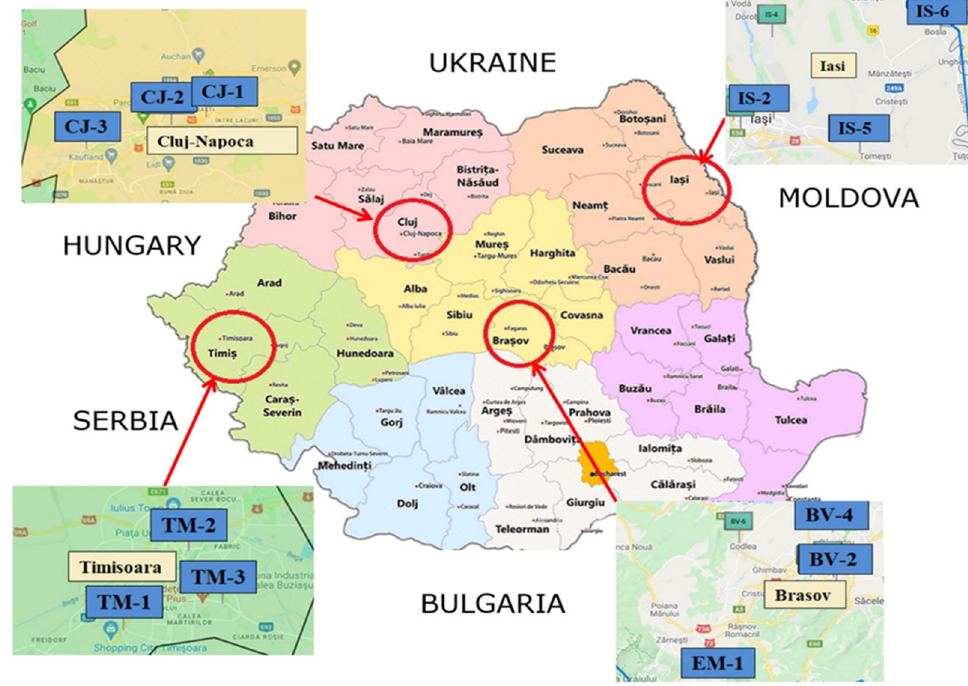
Figure 1. Location of air quality monitoring stations [34].